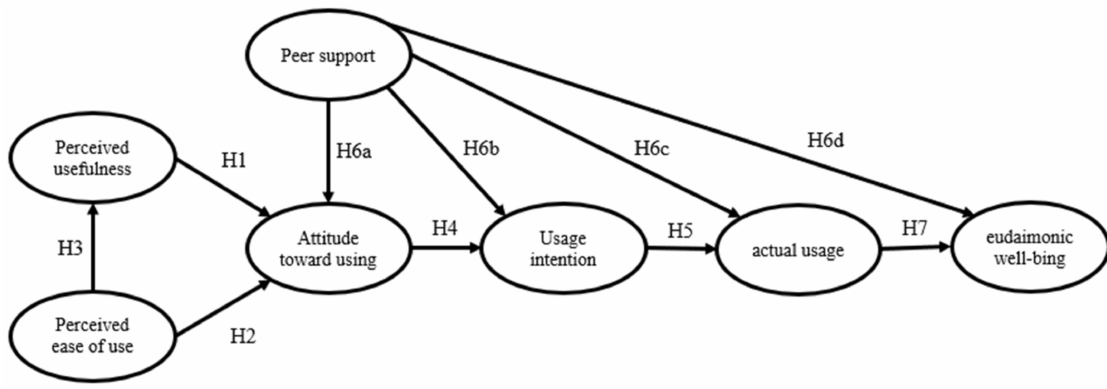
Figure 1. The proposed research